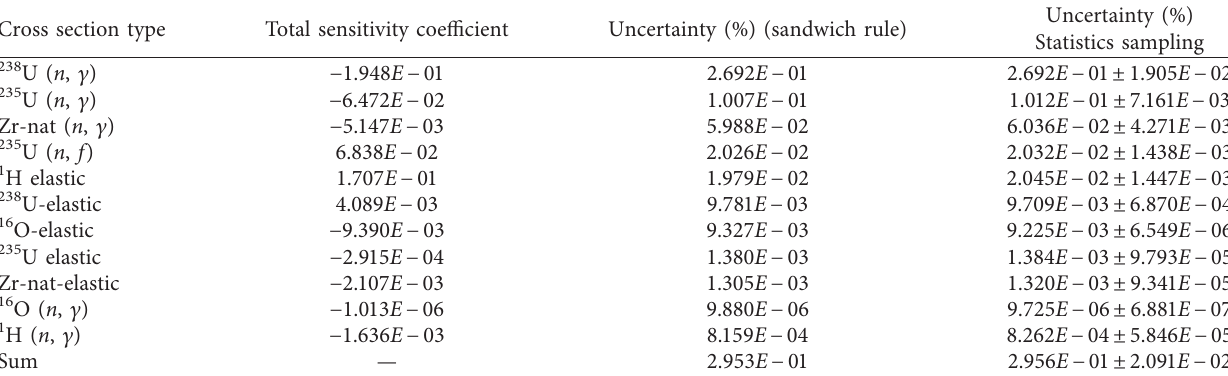
Table 4: The contributions of microscopic cross sections to the k